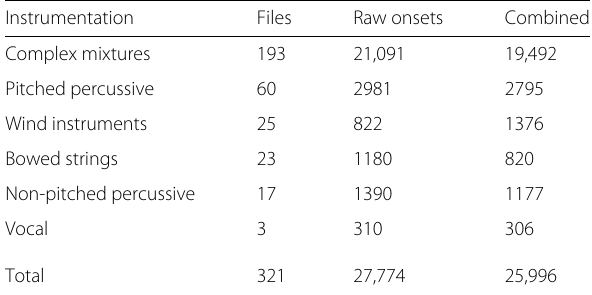
Table 1 Description of the dataset in terms of instrumentation used for evaluation. Reproduced from